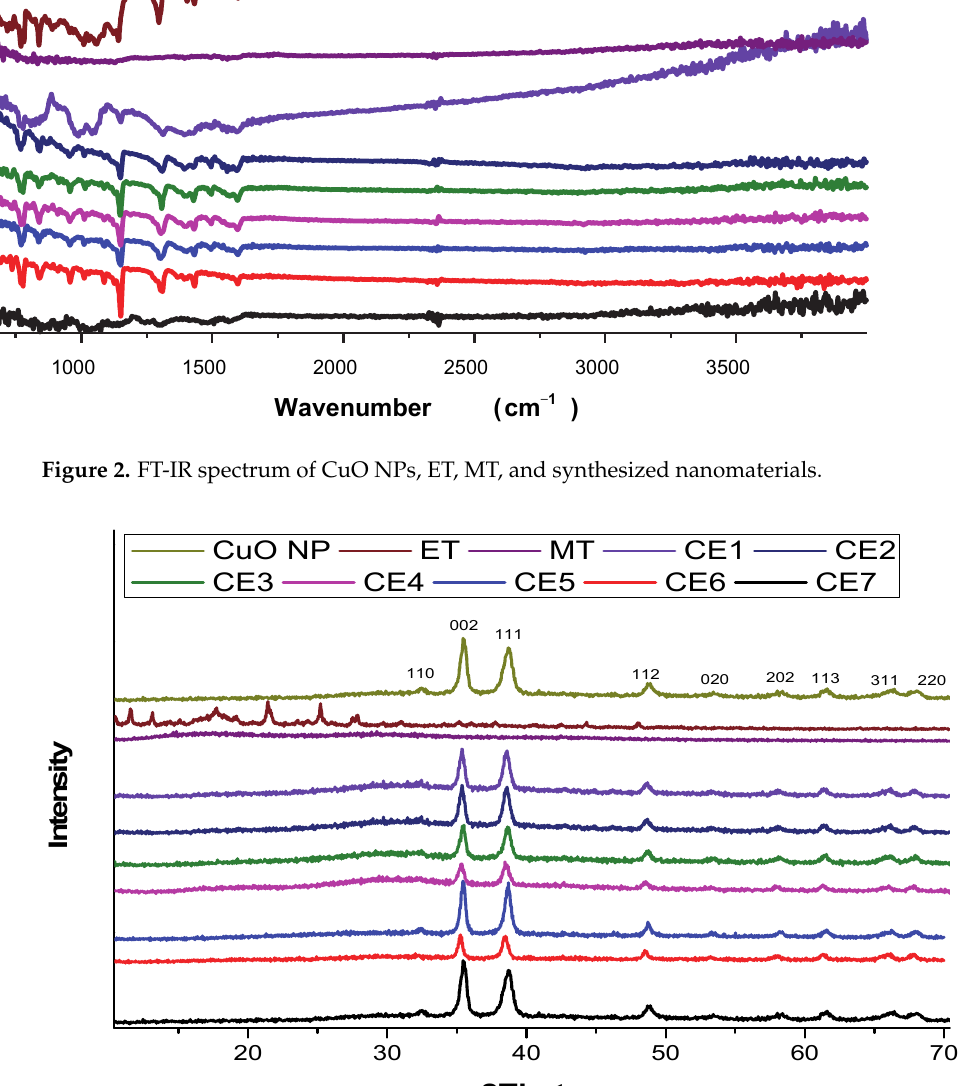
Table 1. Crystallite size of the nanoformulations. Figure 3. XRD spectrum of CuO NPs, ET, MT, and synthesized Figure 3. XRD spectrum of CuO NPs, ET, MT, and synthesized nanomaterials.